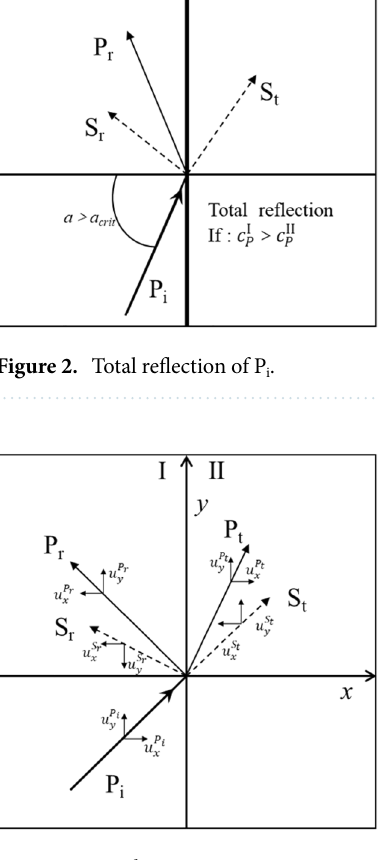
Figure 3. Displacement